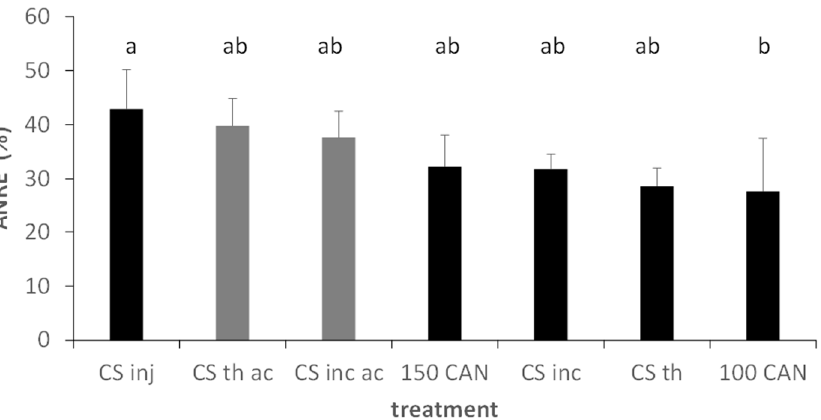
Figure 7. Apparent Nitrogen Recovery Efficiency (ANRE) in the different treatments in summer barley, Foulum, DK, grey colours indicate acidified variants. Fertilization level of applied slurries: 110 kg mineral N. Error bars depict standard deviations. Mixed effects model analysis with HSD post hoc test at p < 0.05. Lowercase letters indicate significant differences between treatments; ac, acidification; CS, cattle slurry; th, trail hose; inj, closed slot injection; inc, incorporation with harrow; 100/150, kg N ha − 1 applied as